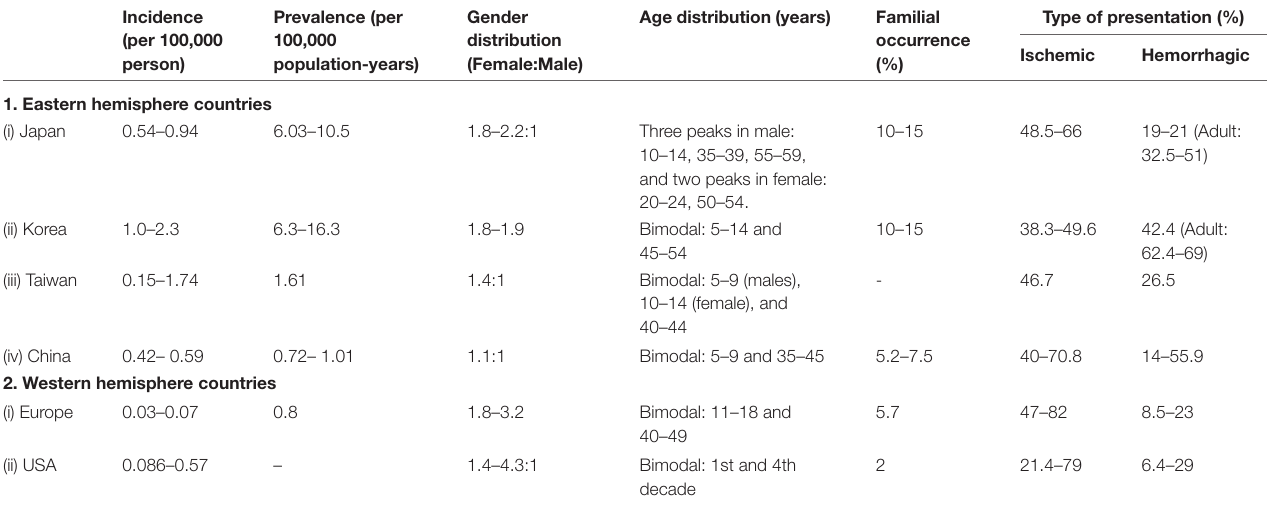
TABLE 8 | Salient epidemiological features of MMA based on recent data from countries around the world.